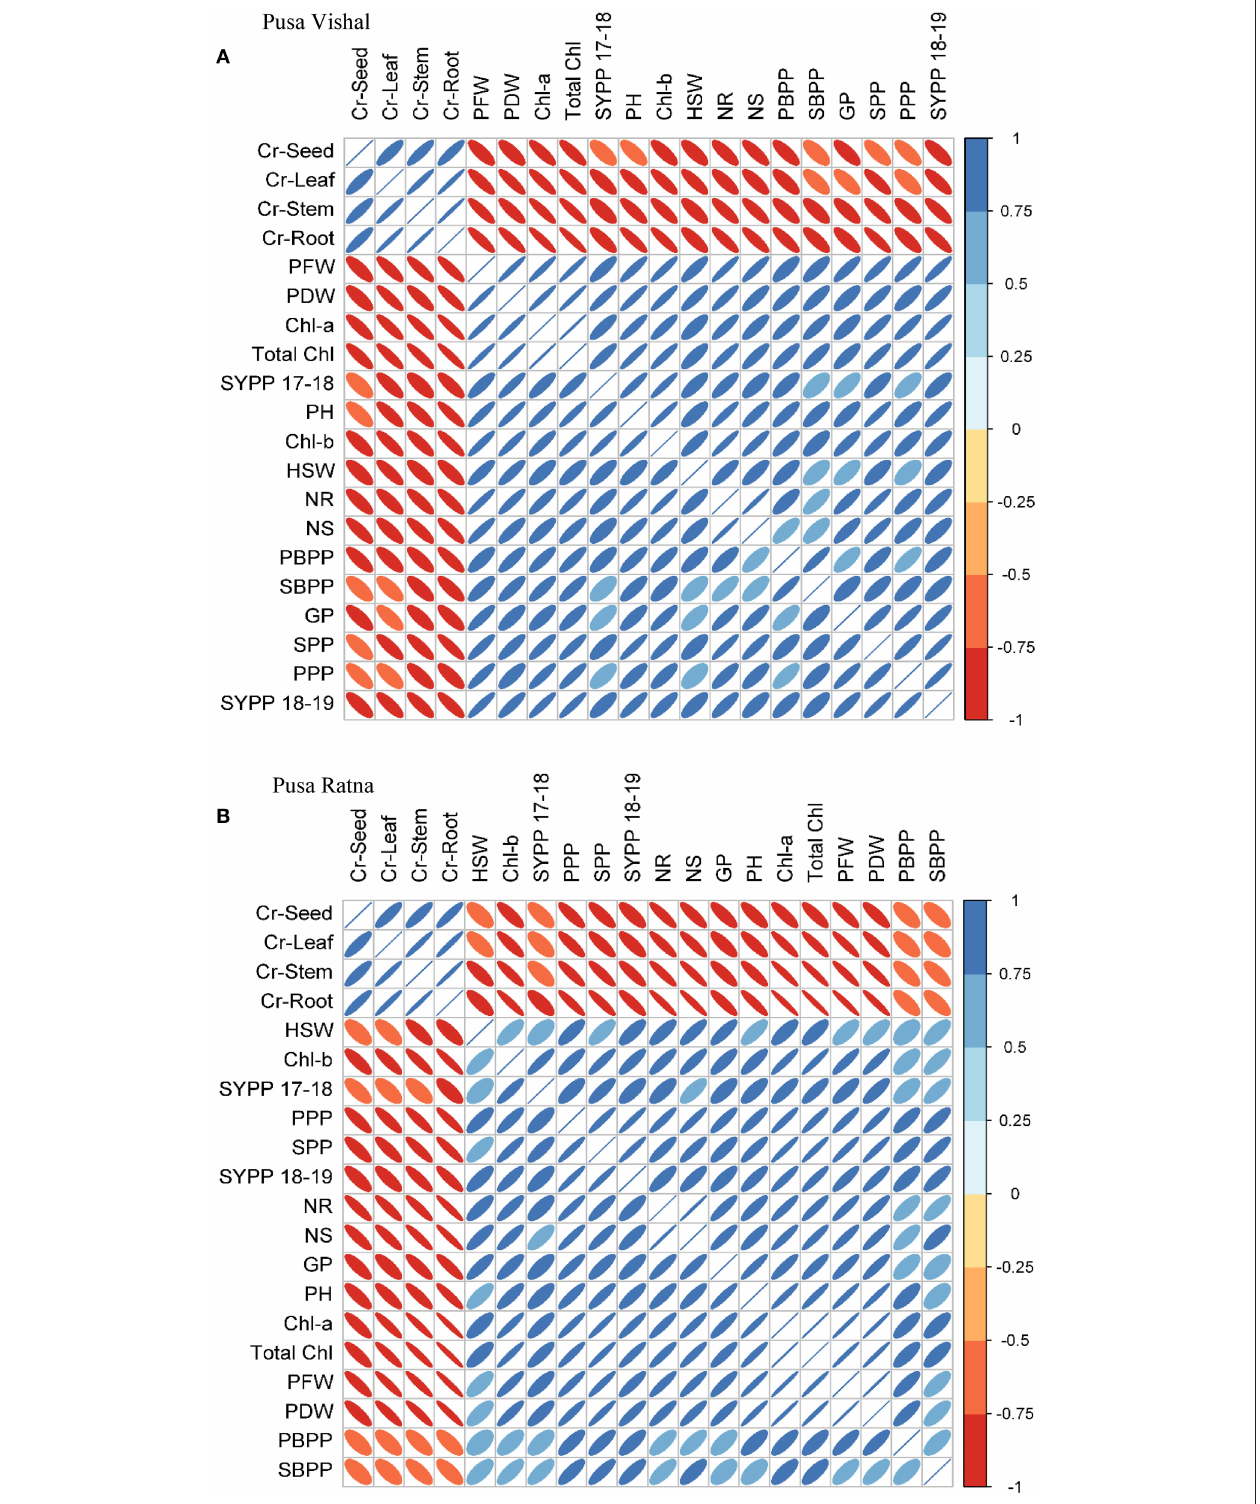
FIGURE 13 | Correlations between different morphological and physiological characteristics and chromium (Cr [IV]) accumulation in different plant parts of (A) Pusa Vishal (PV) and (B) Pusa Ratna (PR) cultivars in pots. PH (Plant height), PBPP (primary branches per plant), SBPP (secondary branches per plant), PFW (plant fresh weight), PDW (plant dry weight), Chl-a (chlorophyll-a), Chl-b (chlorophyll-b), total chlorophyll, NR (nitrogen root), NS (nitrogen shoot), PPP (pods per plant), SPP (seeds per pod), HSW (hundred seed weight), SYPP 17–18 (seed yield per plant 2017–2018), SYPP 18–19 (seed yield per plant 2018–2019) GP (grain protein) and Cr (Leaf, Stem, Root,